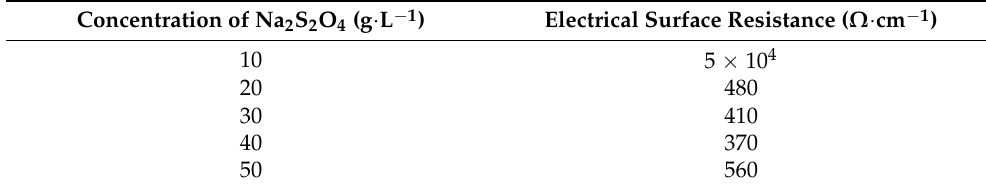
Table 1. The effect of different concentrations of Na 2 S 2 O 4 solution on the electrical surface resistance of the reduced graphene oxide (rGO) membrane (temperature = 50 °C; reduction time = 50 min).